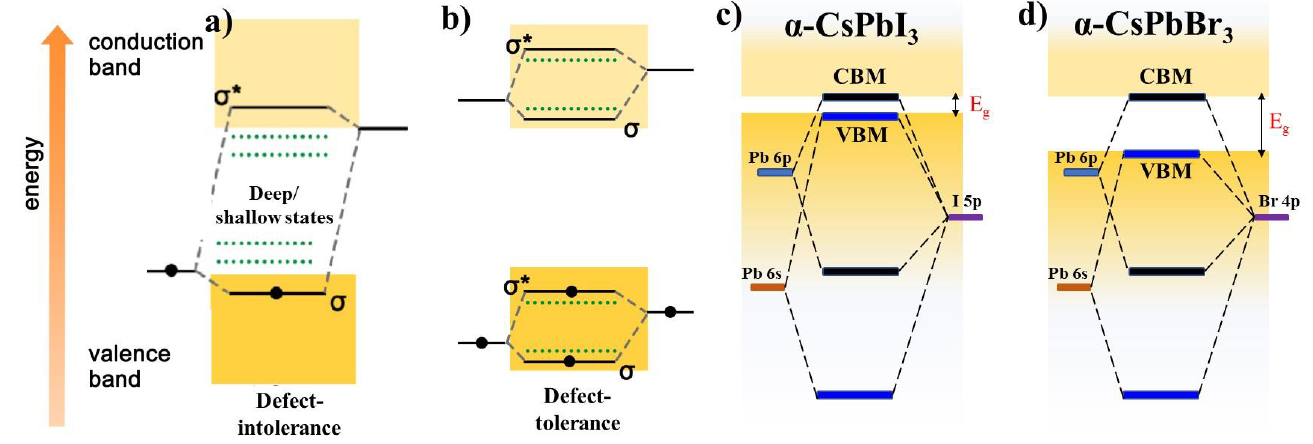
Figure 5. A model electronic band structure of defect-intolerance ( a ) and defect-tolerance ( b ) band structures. σ and σ*, represent the bonding and antibonding orbitals, respectively. ( b ) Schematic of the band structure of α -CsPbI 3 showing the tendency to form traps or shallow states within the conduction band minimum (CBM) and valence band maximum (VBM). ( c , d ) electronic band structure of CsPbI 3 and CsPbBr 3 ( a – d ) are redrawn from Ref. [88], Copyright 2017 American Chemical Society.